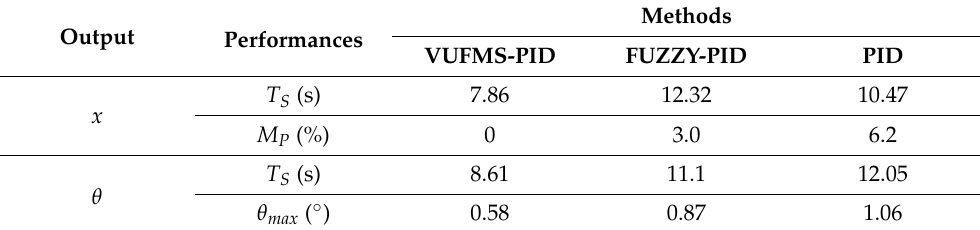
Table 8. Performances obtained using VUFMS-PID, FUZZY-PID, and PID controller under work- ing condition 3.